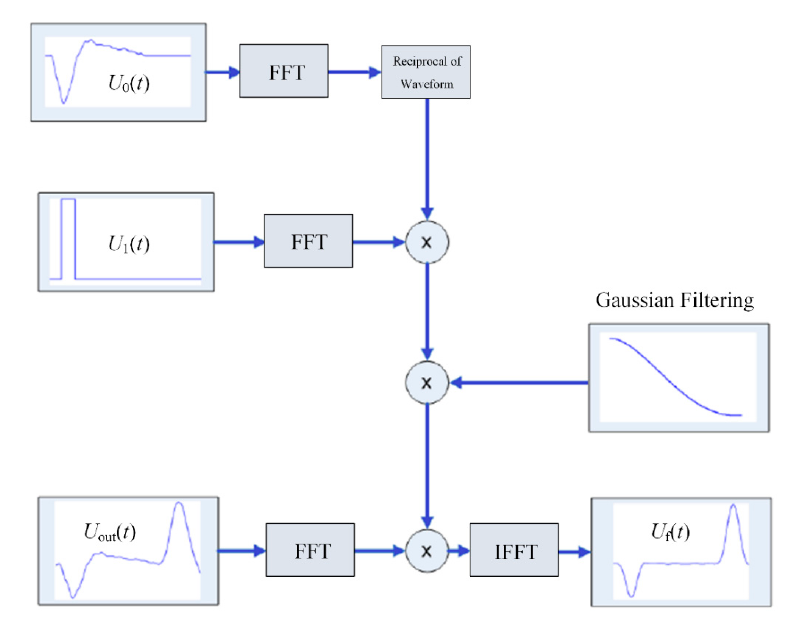
Figure 3. Schematic diagram of the space charge waveform recovery process.